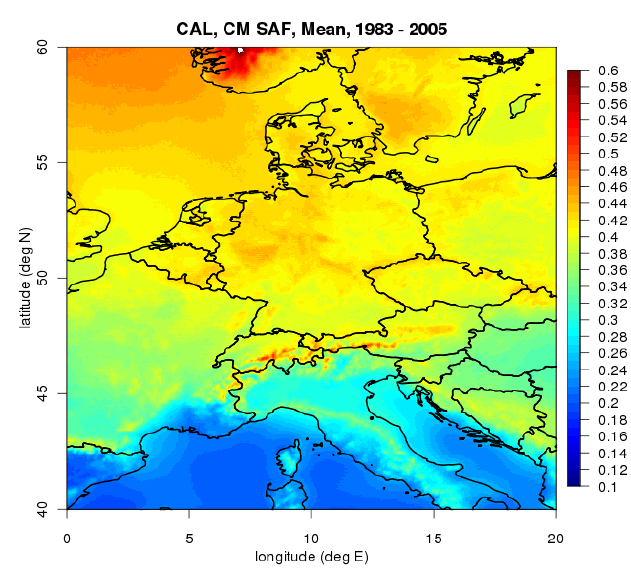
Figure 7. The 23-year mean of the effective cloud albedo for central